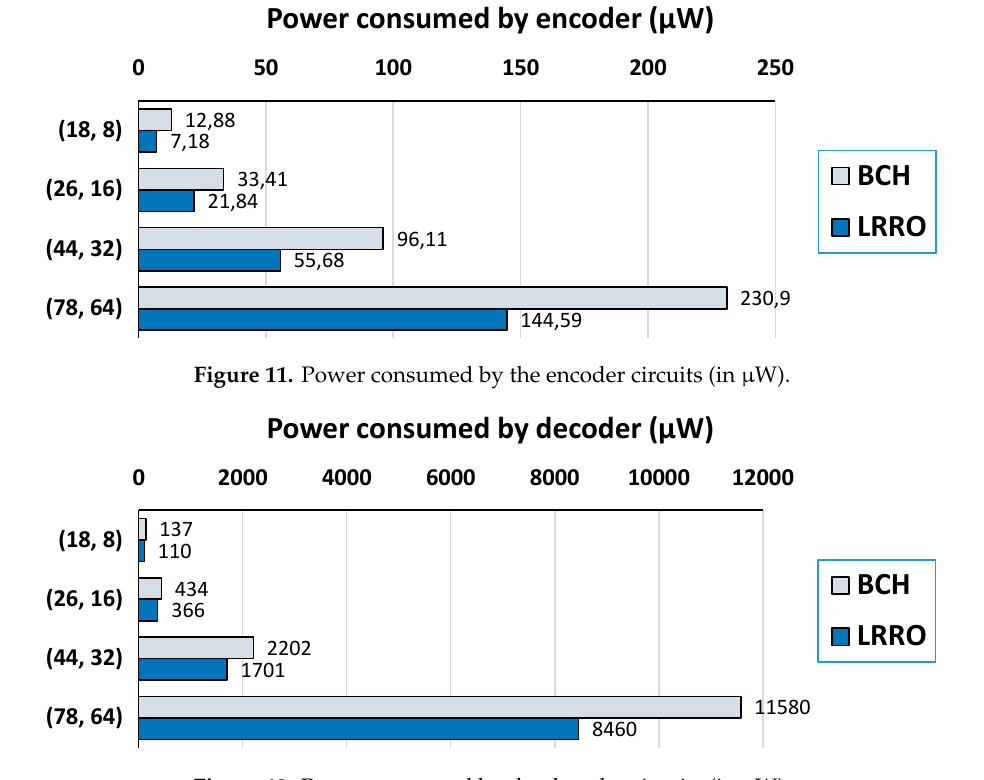
Figure 12. Power consumed by the decoder circuits (in µW).